Question: How would you classify this visualization?
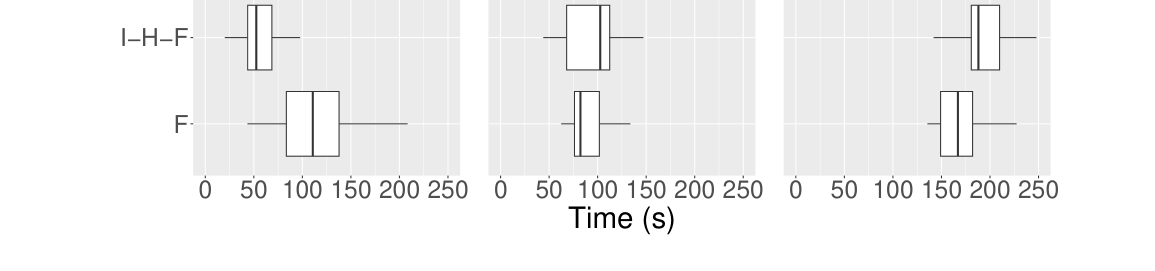
Answer: box